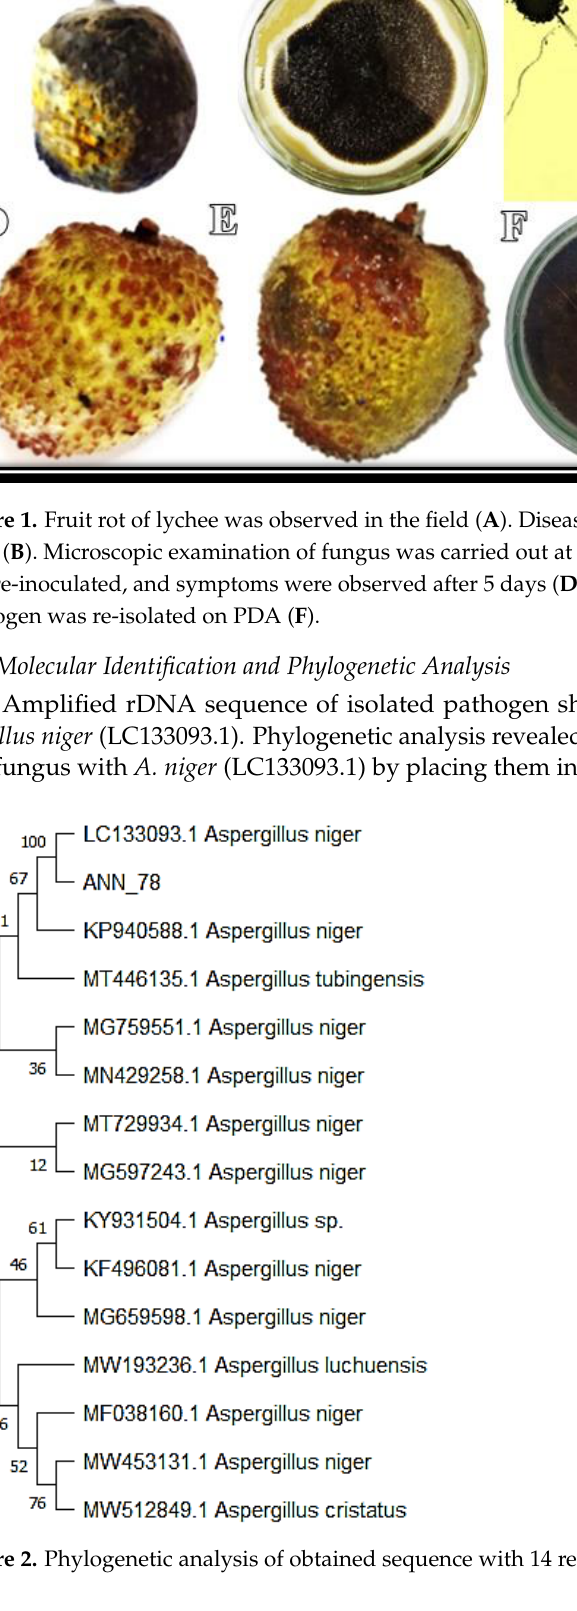
Figure 3. UV Spectroscopy of ZnO NPs. 3.5. FTIR Analysis